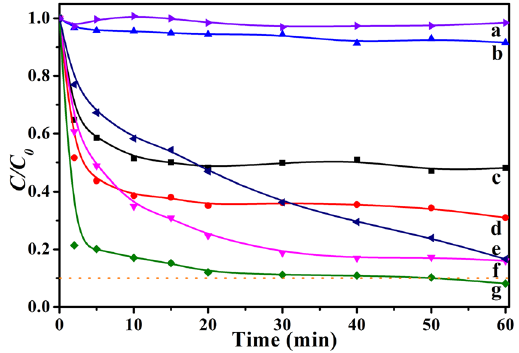
Figure 4. Removal of EtBr under different conditions: (a) 30 mM H 2 O 2 . (b) 1.5 g/L Fe 3 O 4 without H 2 O 2 . (c) 1.5 g/L P-ATP@Fe 3 O 4 without H 2 O 2 . (d) 1.5 g/L A-ATP@Fe 3 O 4 without H 2 O 2 . (e) 1.5 g/L Fe 3 O 4 with 30 mM H 2 O 2 . (f) 1.5 g/L P-ATP@Fe 3 O 4 with 30 mM H 2 O 2 . (g) 1.5 g/L A-ATP@Fe 3 O 4 with 30 mM H 2 O 2 . Other reaction conditions were initial EtBr concentration 80 mg/L, pH 2.0, and T = 323 K, C 0 and C are initial EtBr concentration after 30 min adsorption and its concentration at any time during the reaction,